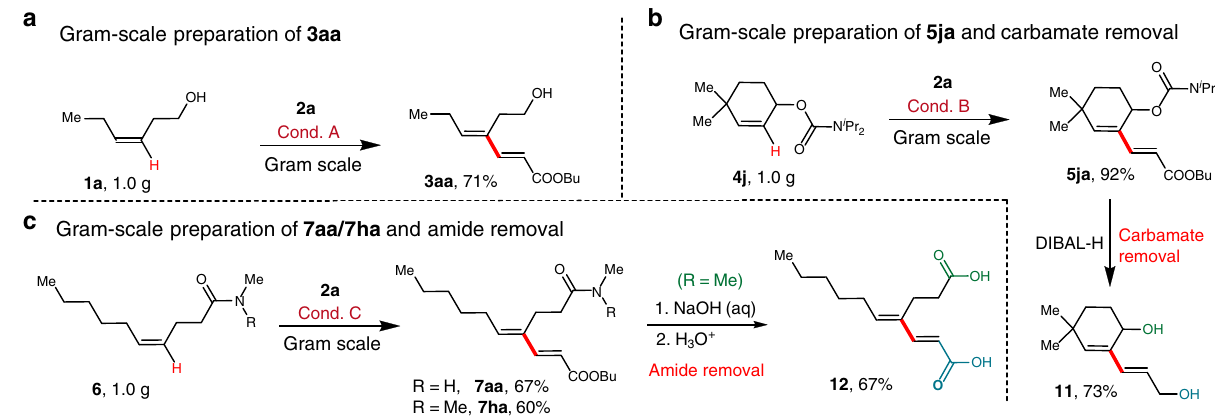
Fig. 3 Gram-scale synthesis and directing group removal. a Gram-scale synthesis of compound 3aa . b Gram-scale synthesis of compound 5ja and carbamate removal. c Gram-scale synthesis of compound 7aa/7ha and amide removal